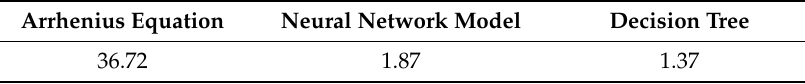
Table 4. Root mean square error comparison for three approach.